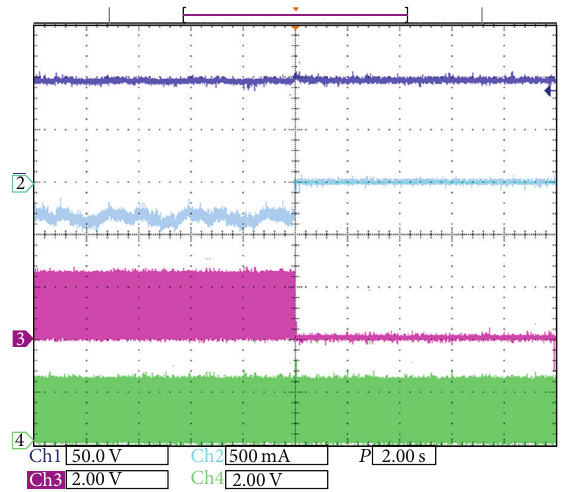
Figure 19: Operation when battery set charging stops from top to , 𝑆 2 , and 𝑆 1 . bottom: 𝑉 𝑜 , −𝐼 𝐿 2